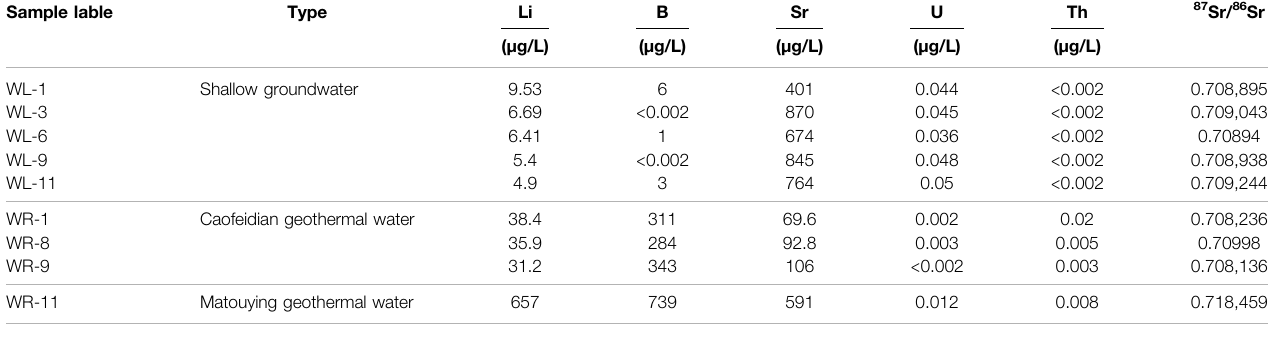
TABLE 4 | Trace elements (Li, B, U, Th, Sr) and 87 Sr/ 86 Sr characteristic of geothermal water at the Caofeidian and the Matouying.